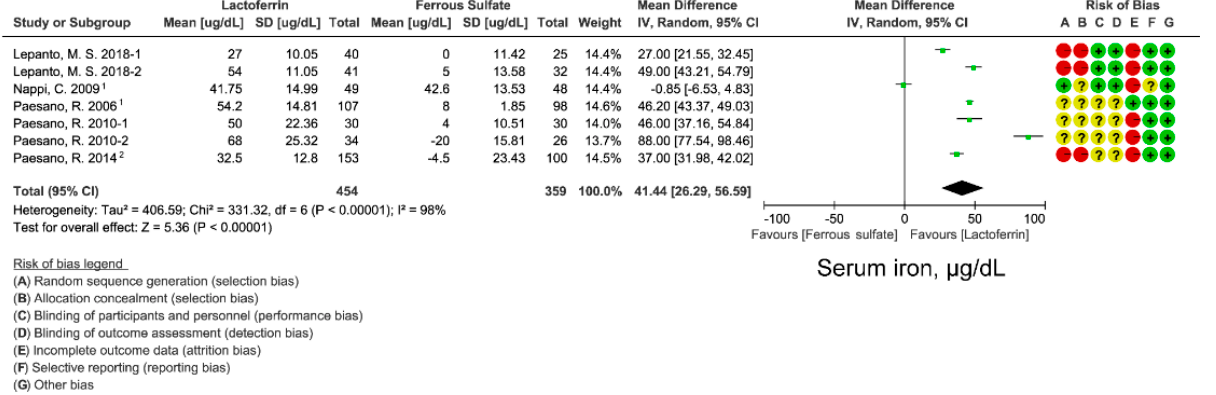
Figure 2. Effect of lactoferrin and ferrous sulfate on serum iron (SI). 1, converted from median and minimum-maximum range. 2. Mean and SD were estimated from histogram. Risk of bias legend: A = random sequence generation (selection bias); B = allocation concealment (selection bias); C = blinding of participants and personnel (performance bias); D = blinding of outcome assessment (detection bias); E = incomplete outcome data (attrition bias); F = selective reporting (reporting bias); G = other bias. Data expressed as weighted mean difference (95% CI). IV, inverse variance.